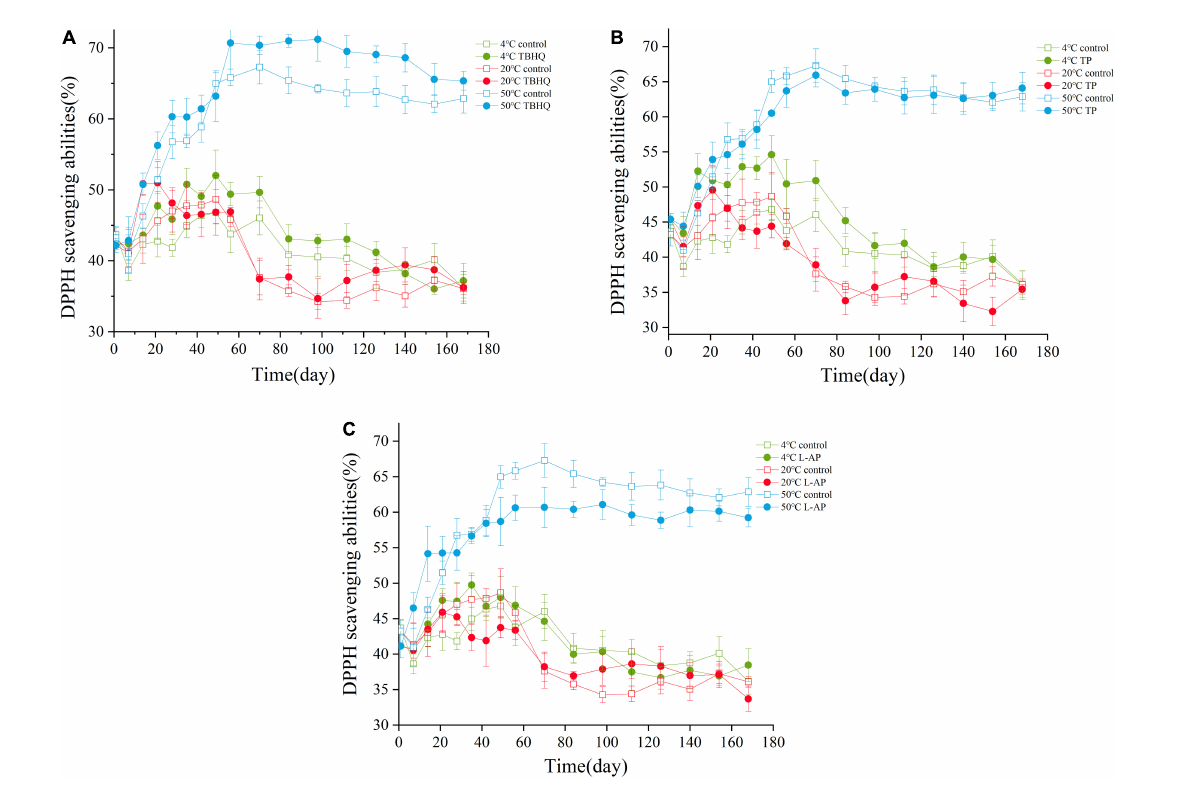
FIGURE2 Levels of DPPH during the storage of HPBF with the addition of TBHQ (A) , TP (B) , and L-AP (C) . The discrimination of the shape is shown to distinguish the control group and the treatment groups. The color discrimination represents various temperature (4, 20, and 50 ◦